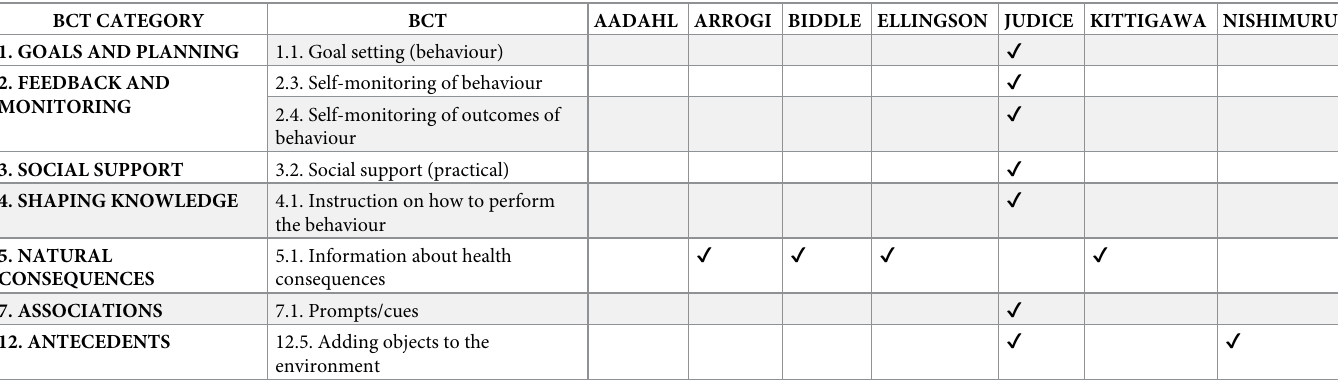
Table 5. Behaviour change techniques per control